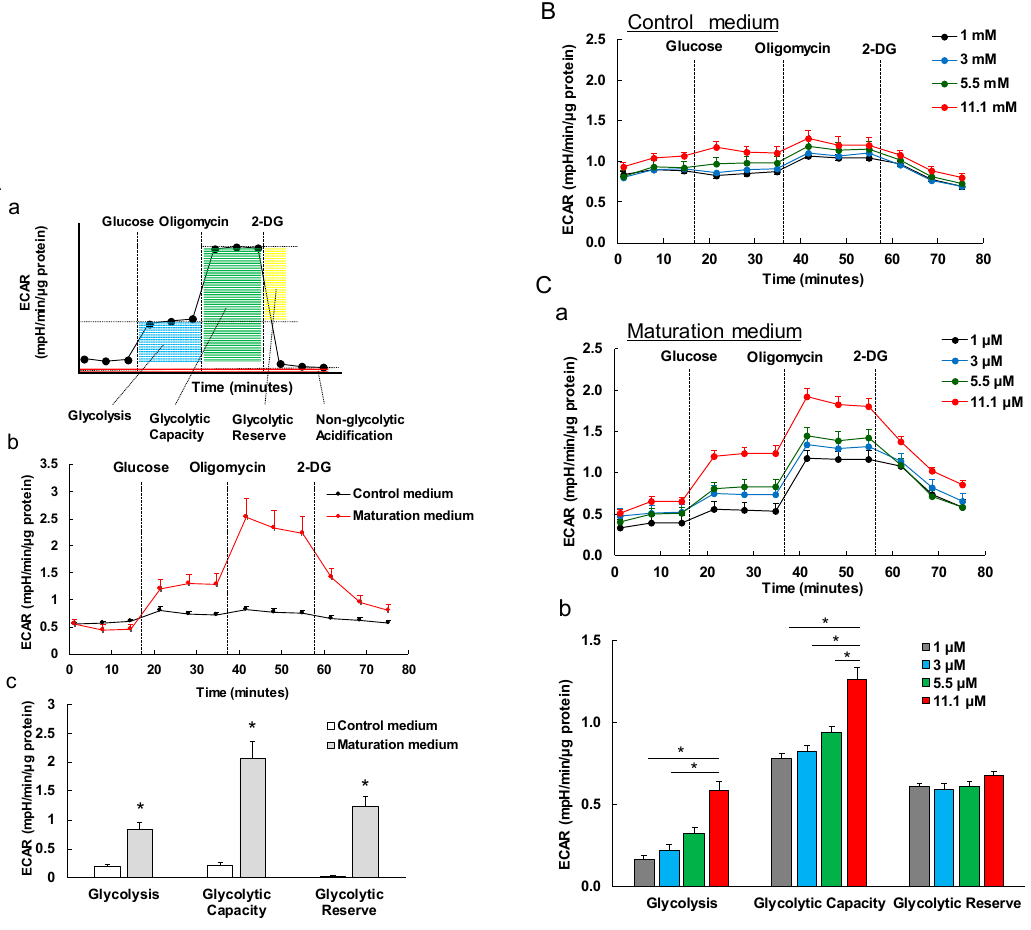
Figure 6. The effect of maturation medium on glycolytic function of iPSC-CMs (day 34) via analysis of the extracellular acidification rate (ECAR) of 1013 iPSC-derived CMs. ( A -a) This diagram depicts (1) the representative traces of ECAR on the cells after sequentially adding 5.5 µM glucose, 10 µM oligomycin, and 25 mM 2-DG to the culture and (2) the profiles of key parameters of glycolytic function are glycolysis (blue), glycolytic capacity (green), glycolytic reserve (yellow), and non-glycolytic acidification (red). ( A -b) Representative two ECAR traces of iPSC-CMs treated with control and maturation medium for 3 days, respectively. ( A -c) The quantified ECAR shows that maturation medium increased glycolysis, glycolytic capacity, and glycolytic reserve of iPSC-CMs, suggesting that matured iPSC-CMs have a higher capacity to switch to glucose utilization when fatty acid oxidation is compromised. n = 4, * p < 0.05 vs. control medium. ( B ) The effects of different concentrations of glucose on glycolytic function of the control medium-treated iPSC-CMs. There is no significant difference in glycolytic function for each glucose concentration. ( C -a) Representative traces of ECAR of matured iPSC-CMs in response to various glucose concentrations. ( C -b) The glycolysis and glycolytic capacity exhibited the response to the glucose in a dose-dependent manner. n = 4, * p < 0.05.